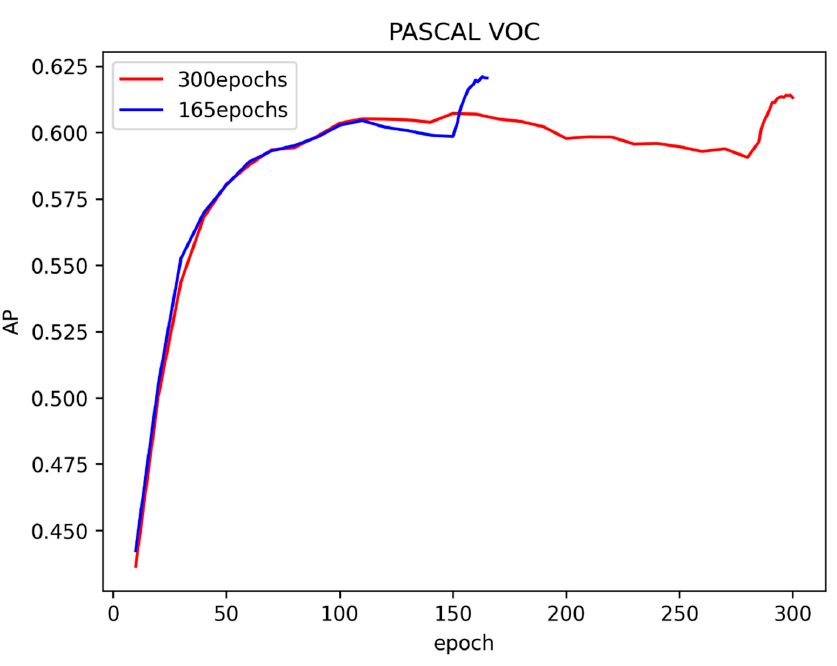
Figure 8. The AP comparison chart of EYOLOX training PASCAL VOC 07+12 on the validation set. The blue curve represents the result of iteration 165 epochs, and the red curve represents the result of iteration 300 epochs.